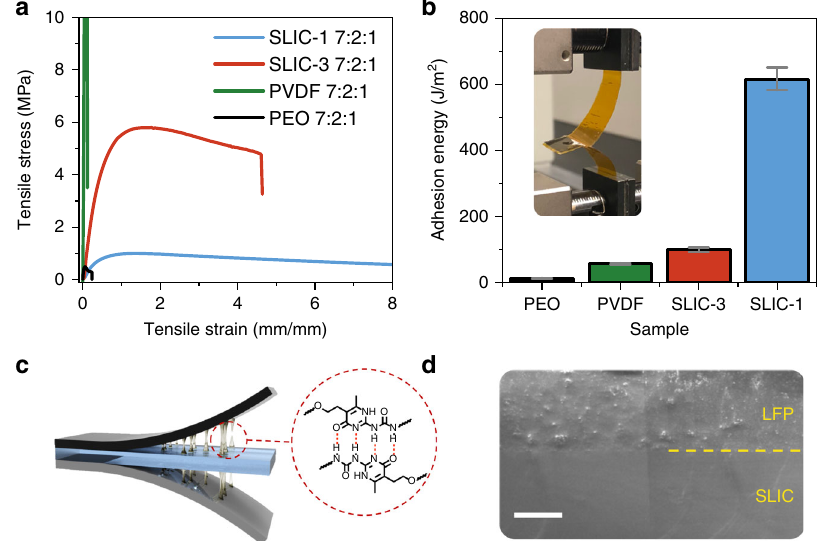
Fig. 4 Use of SLIC to construct stretchable electrode materials. a stress-strain curves of polymer composite electrodes with different amounts of LFP and carbon black. The ratios given are in terms of Polymer:LFP:CB. No other components (DEGDME/SiO 2 ) are included. The strain rate is 100 mm/min. b Adhesion energy between the SLIC electrolyte and various composite electrodes with composite ratio of 7:2:1. Inset shows an optical image of the measurement setup. c Schematic showing the formation of dynamic UPy bonds at the electrode-electrolyte interface. d SEM image of the interface between SLIC-3 electrolyte and a 7:2:1 SLIC-1 based electrode. Scale bar is 25 µ